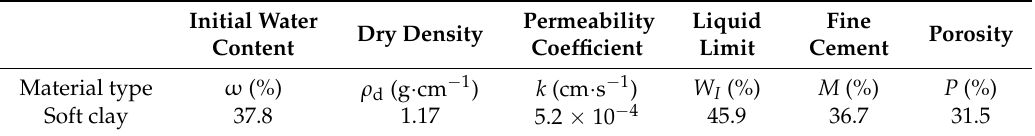
Table 1. Basic physical parameters of the soil